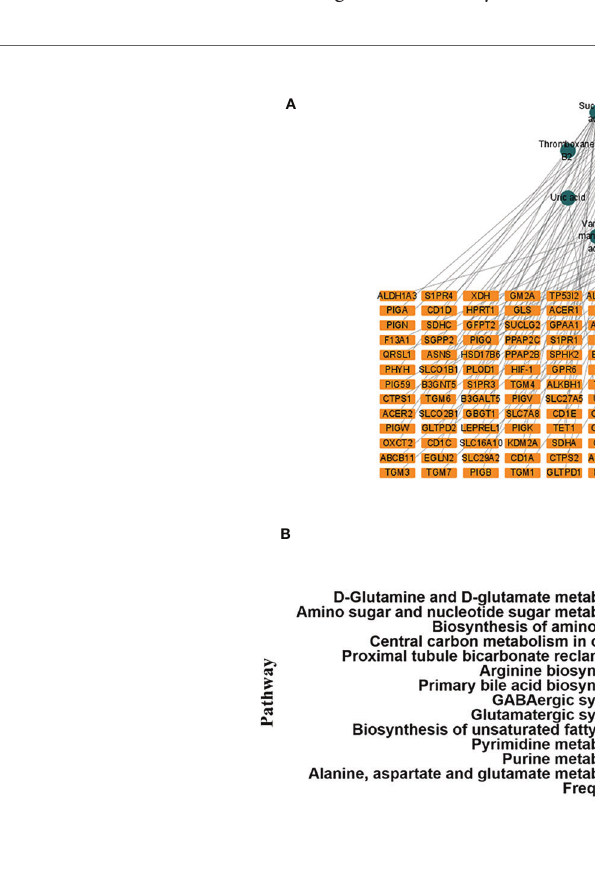
FIGURE 7 | The connected network of metabolites and genes in graph (A) . The orange rectangles circles node represents the differentially expressed metabolites in the preoperative group vs. postoperative group. The blue rectangles represent the genes closely correlated with those metabolites. The Kyoto Encyclopedia of Genes and Genomes (KEGG) enrichment pathways in the preoperative group and postoperative group in graph (B)